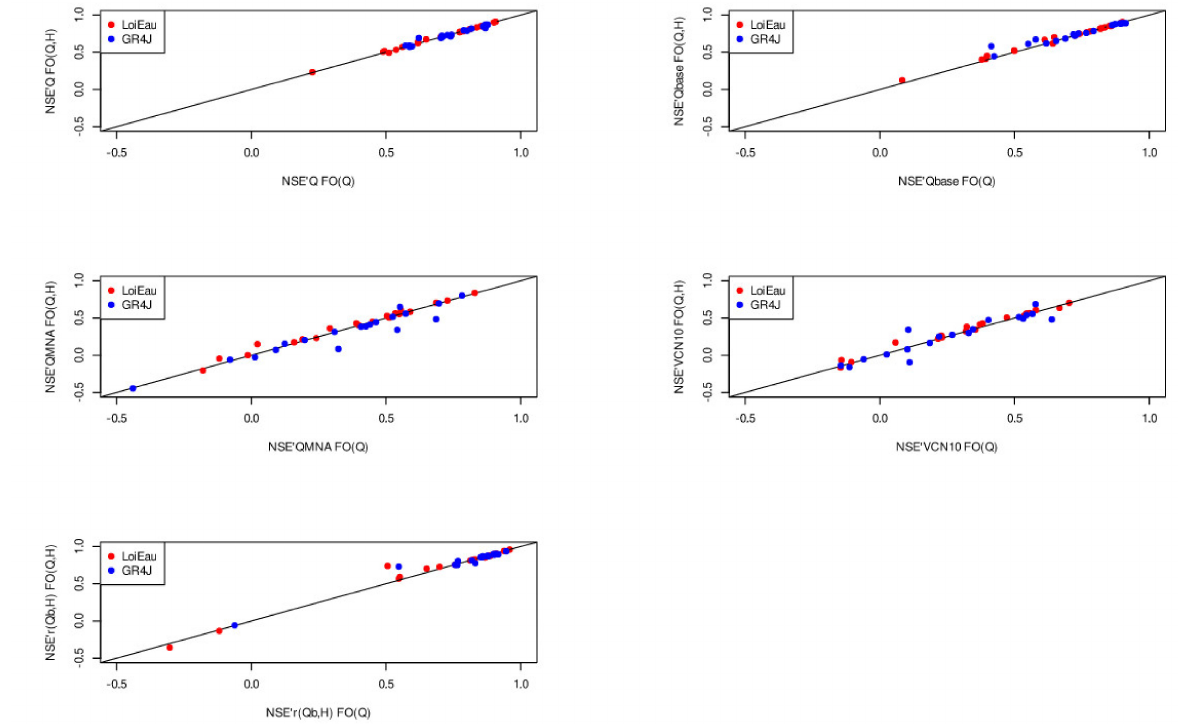
Figure 7. Comparative distribution of the evaluation criteria of two objective functions FO (Q) and FO (Q, H) for LoiEau and GR4J and for the two validation